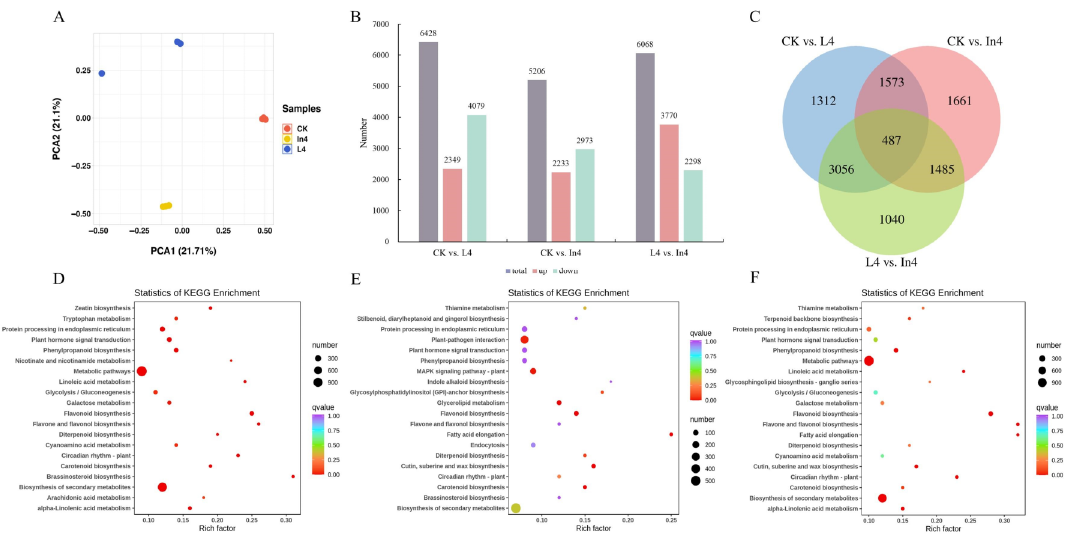
Figure 7. Identification and functional enrichment of differentially expressed genes in P. koraiensis under different supplementary lights. ( A ) PCA score plot of expression profiles from different samples. ( B ) The statistics of upregulated and downregulated DEGs in different comparison groups. ( C ) Venn diagram of DEGs in different comparison groups. ( D ) The top 20 KEGG enrichment pathways of DEGs in CK vs. L4. ( E ) The top 20 KEGG enrichment pathways of DEGs in CK vs. In4. ( F ) The top 20 KEGG enrichment pathways of DEGs in L4 vs. In4. CK: Control. L4: Supplementary LED for 4 h. In4: Supplementary incandescent lamp for 4 h.